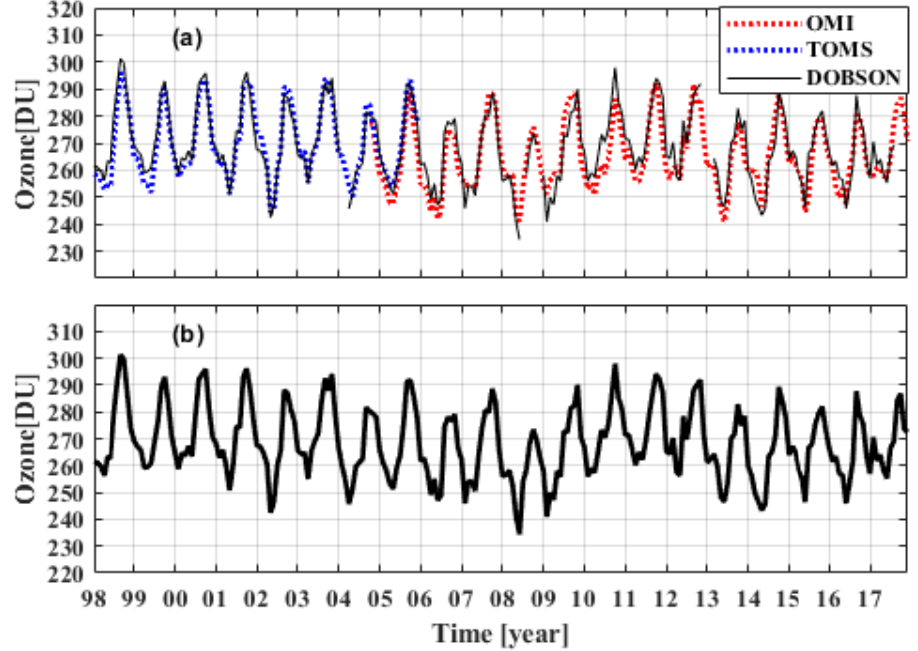
Figure 2. ( a ) Monthly average values of total columns of ozone (TCO) measured by Dobson (red), Total Ozone Mapping Spectrometer (TOMS) (dotted red line), and Ozone Monitoring Instrument (OMI) (dotted blue line) instruments over Irene station. ( b ) Time-evolution of TCO constructed combining Dobson and satellite data.